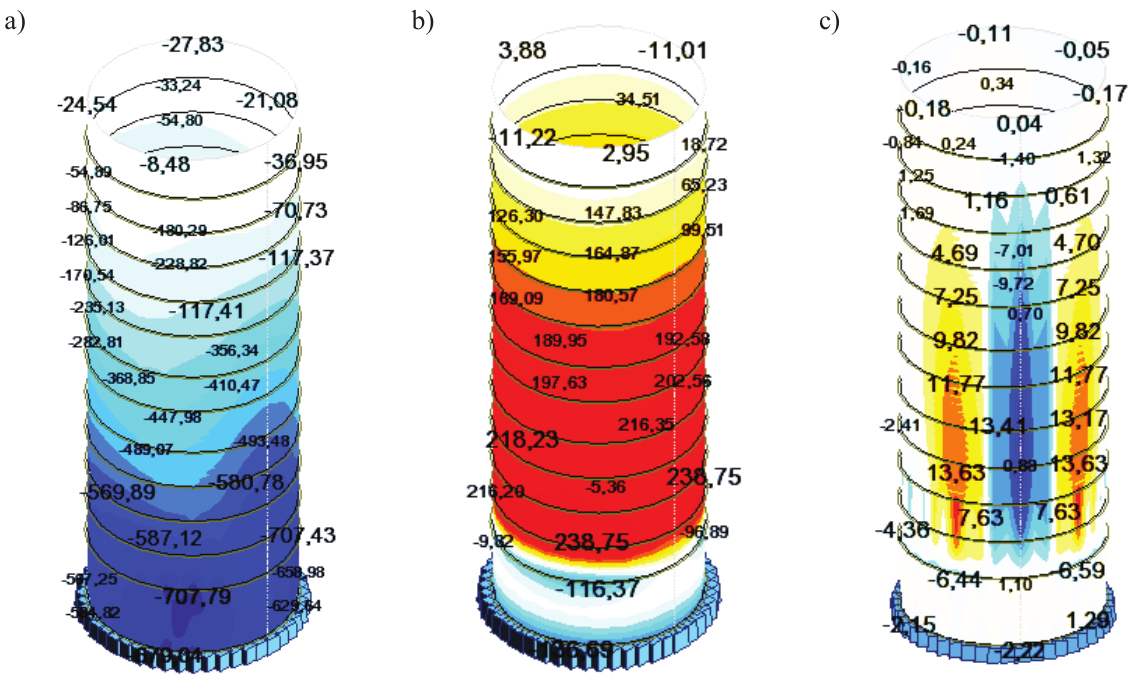
= 10 m on a large eccentric taking into account the c = 0.6 r ( c ,3 c